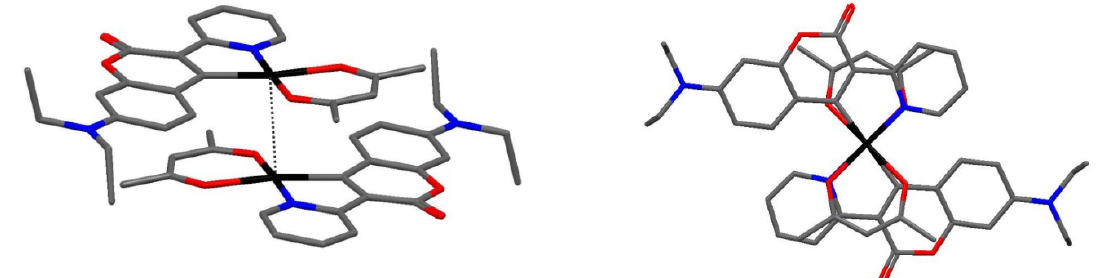
Figure 2. Side and top view on two molecules of 1 that associate through a short Pt∙∙∙Pt contact of 3.164(1) Å and π-stacking of 3.33